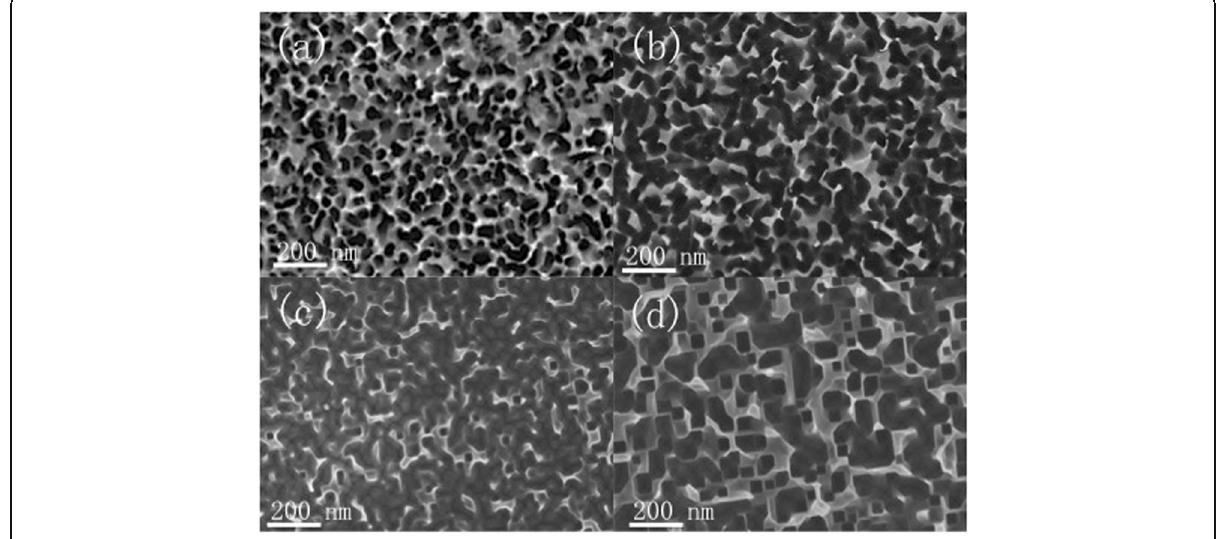
Fig. 1 SEM images of different Si nanostructure. a As-fabricated Si NW, Si NW with TMAH etching time of b 50, c 60, and d 70